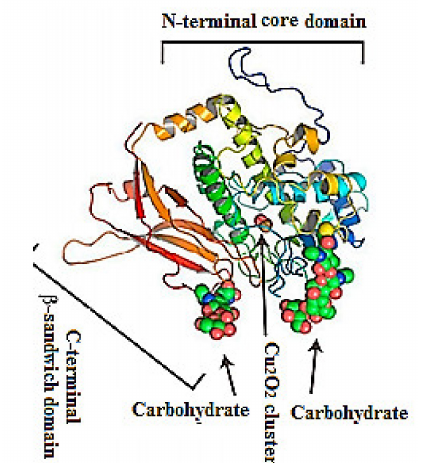
Figure 2. Representative ribbon diagram of FU-d of Todarodes pacificus squamous hemocyanin, colored as a ramp from blue (N-terminus) to red (C-terminus). The Cu 2 O 2 cluster and carbohydrates